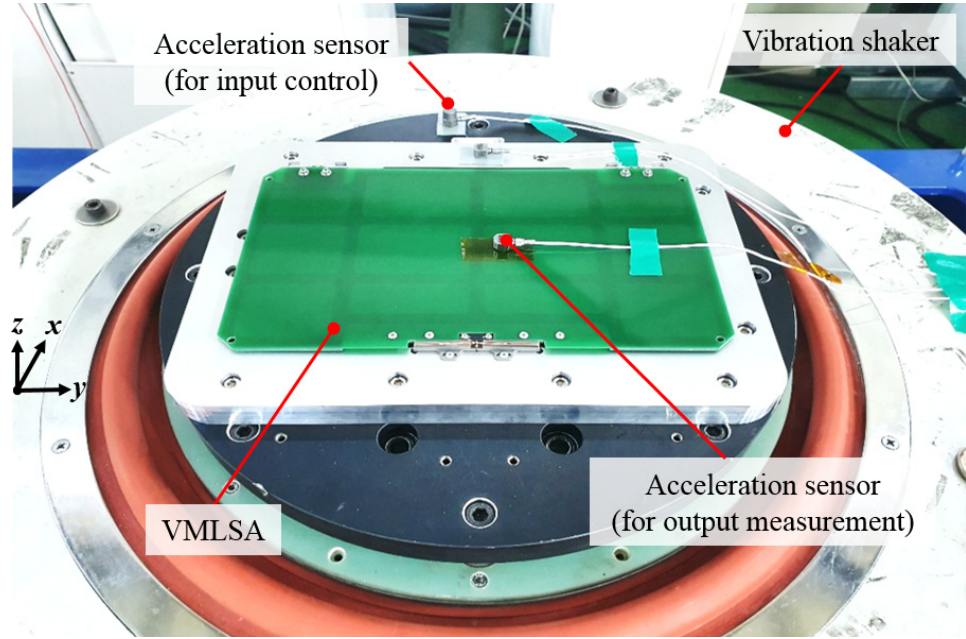
Figure 13. An example of launch vibration test setup of VMLSA on a vibration shaker.